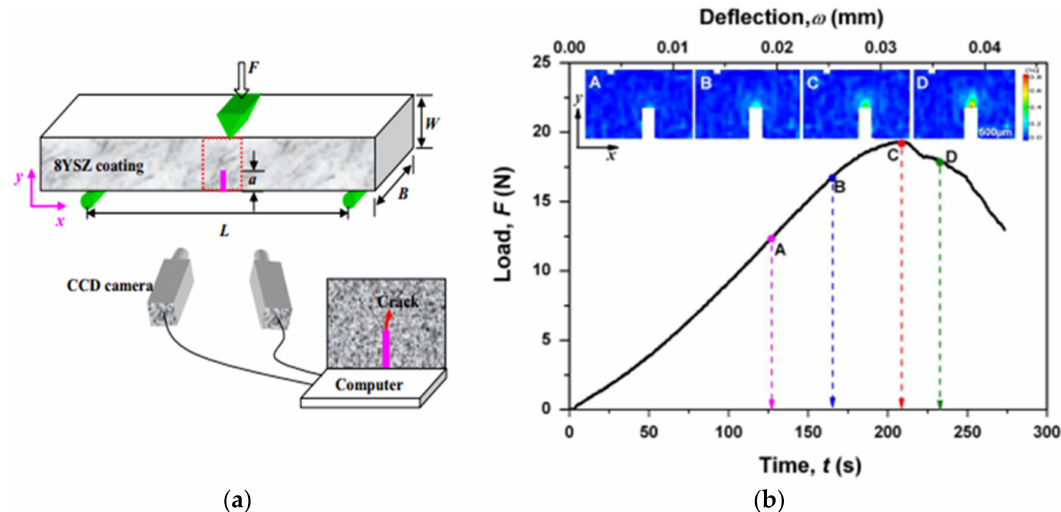
Figure 18. ( a ) Schematic showing SENB test with the aid of the DIC system, ( b ) loading–deflection– time data of 8YSZ specimens during SENB. Different strain fields (insets A, B, C, and D) showing the evolution of strain with the increase in bending loads